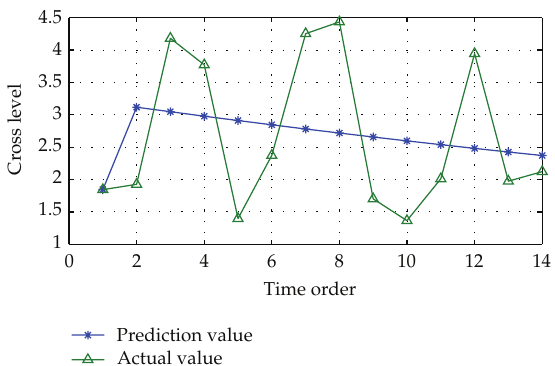
Figure 6: Comparison of actual state and predictive state at unit